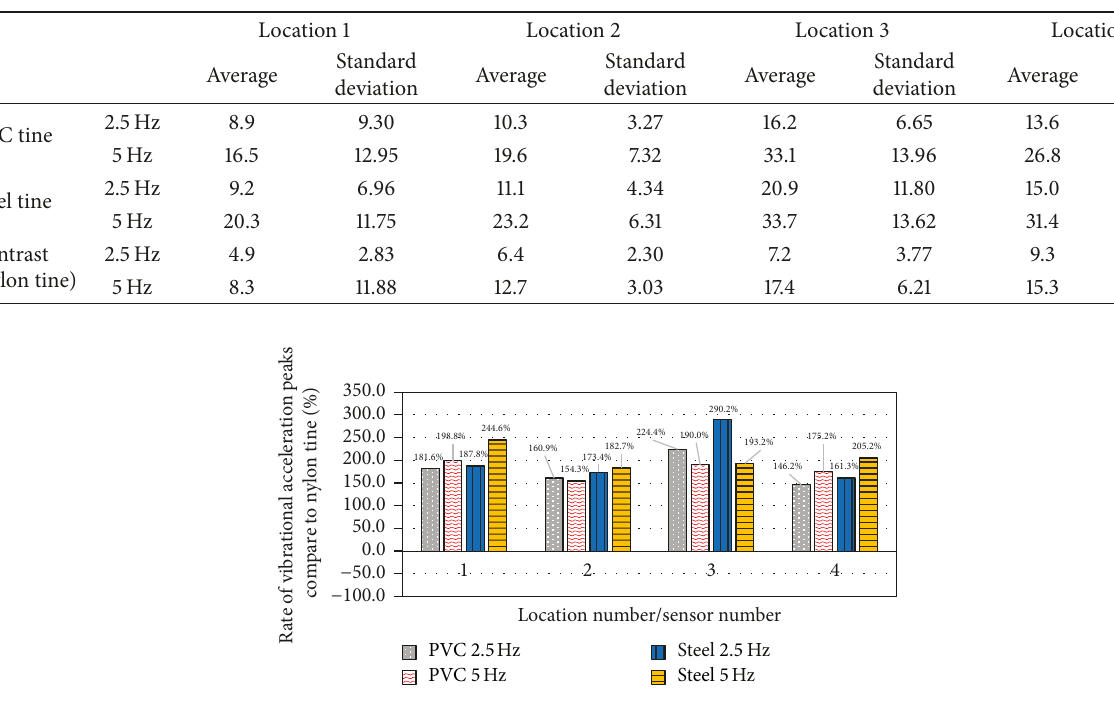
Table 4: The average of the median of the resultant acceleration peaks for trial 2 (m/s 2 ).